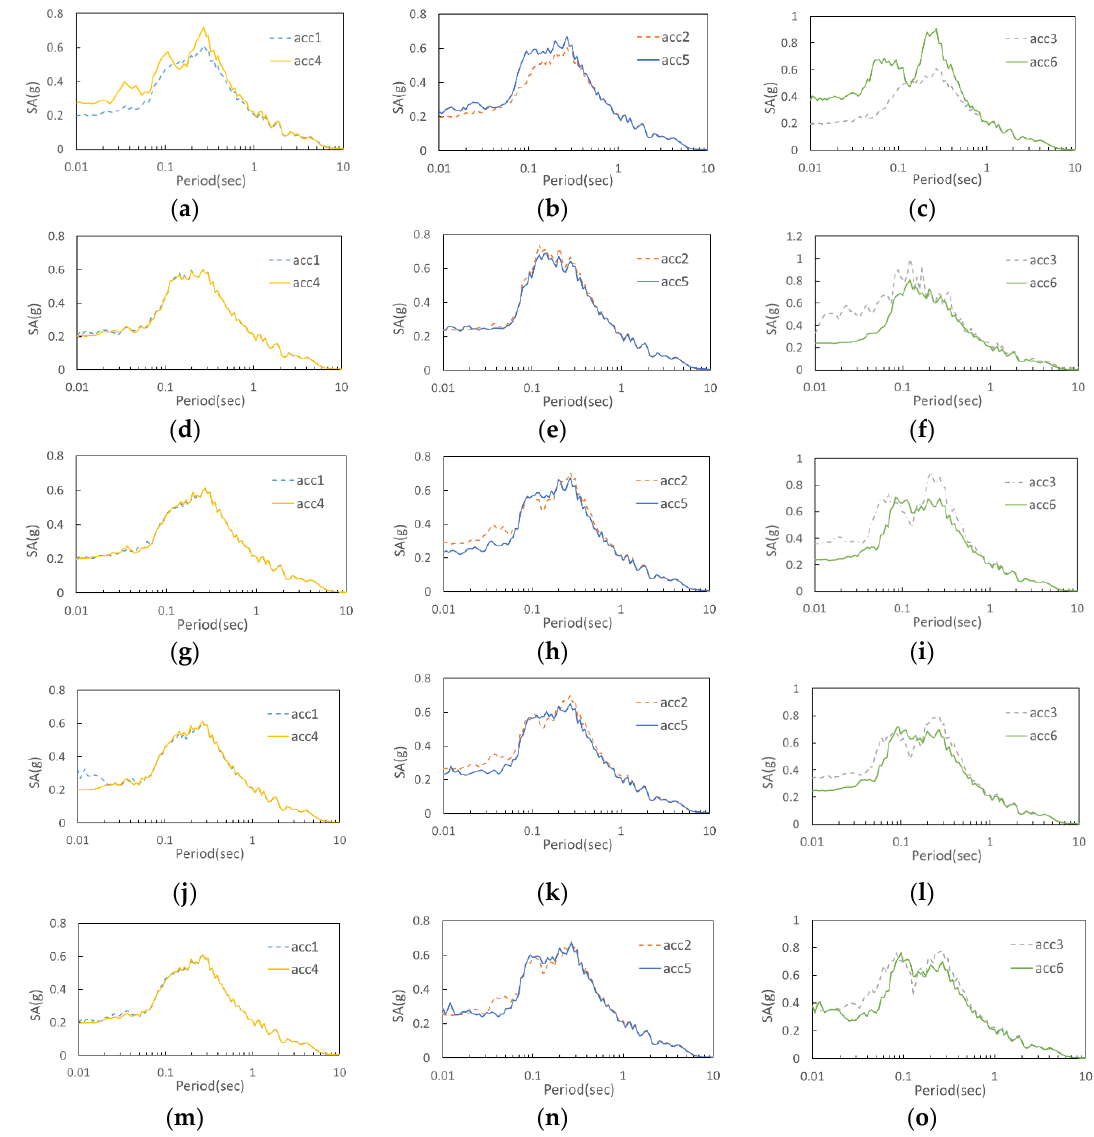
Figure 11. Acceleration spectra by depth: ( a ) Depth 0.4 m of RB; ( b ) Depth 0.2 m of RB; ( c ) Surface of